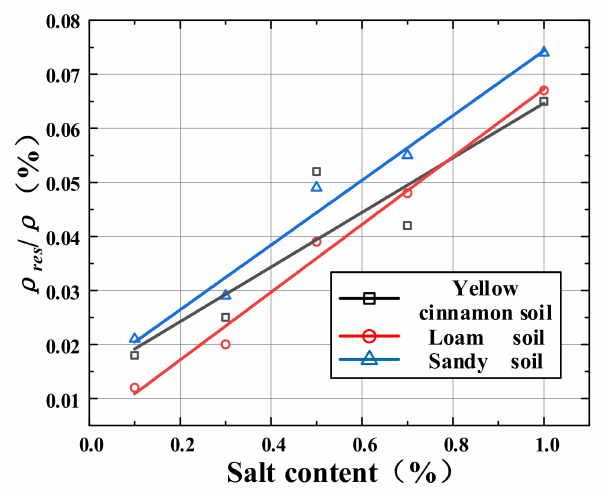
Figure 9. The influence of salt content on ρ res under different soil